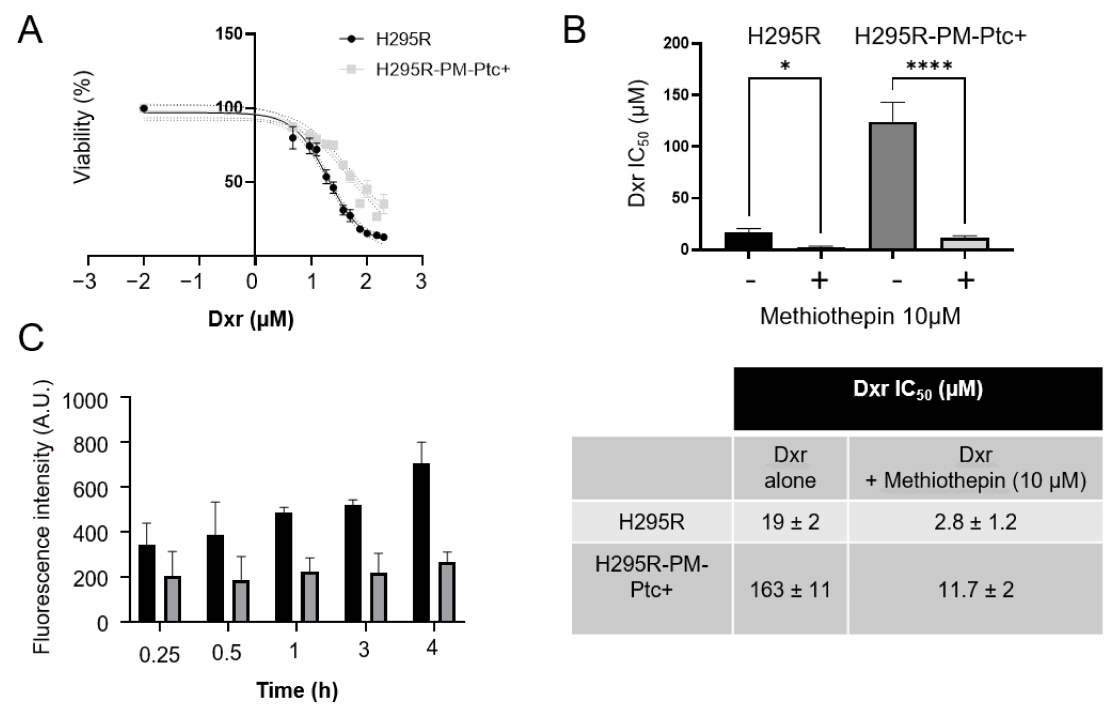
Figure 1. Gene structure of dog OCT1. ( A ) Sashimi plot showing OCT1 (SLC22A1) RNA-Seq Figure 2. H295R-PM-Ptc+ cells are more resistant to chemotherapy than parental cells . ( A ) Dox- reads from Beagle dog liver mapped onto chromosome 1 of the CanFam3.1 dog genome assembly. orubicin (dxr) cytotoxicity. H295R and H295R-PM-Ptc+ cells were treated for 48 h with increasing Exon junctions based on spliced reads are connected by lines, with the number indicating the concentrations of dxr before cell viability measure. ( B ) Doxorubicin IC50 of H295R-PM-Ptc+ and number of splice junctions mapped. RNA-Seq dataset PRJEB33381 from ENA at EMBL-EBI was H295R parental cells in the absence or the presence of 10 µ M of the Ptch1 efflux inhibitor methiothepin. used. ( B ) Exon-intron structure of dog OCT1 according to the CanFam3.1 genome assembly (top) ( C ) H295R-PM-Ptc+ cells accumulate less doxorubicin than parental H295R cells. Cells on coverslips and our experimental determination (bottom). The experimentally determined structure contains an were incubated with 2 µ M dxr for 15, 30, 60, 180 and 240 min and immediately fixed with PFA. Dxr additional exon between exons 2 and 3 of the CanFam3.1 genome assembly. ( C ) Schematic protein fluorescence was acquired using a filter for Alexa 594 and quantified using ImageJ software. About sequence alignment of human OCT1 (green) and dog OCT1 according to CanFam3.1 (grey) and 100 cells (from three wells) were scored per condition per experiment. All data presented are the our experimental results (blue). ( D ) Comparison of RNA-Seq coverage mapped onto dog OCT1 mean ± SEM of at least 3 independent experiments. Significance is attained at p -value < 0.05 (*), cDNA sequences according to CanFam3.1 (grey) and our experimental determination (blue). The (**** p < x-axis numbering represents the cDNA sequence based on the experimentally determined dog OCT1 sequence and the exon structure shown below. RNA-Seq datasets PRJNA396033 (Newfoundlander, Labrador Retriever, and Yorkshire Terrier) and PRJNA601830 (Boxer) from NCBI GEO were used. In contrast, when we mapped RNA-Seq datasets from dog kidney for OCT2 using the same reference genome (CanFam3.1), no differences between the annotated dog OCT2 gene structure (CanFam3.1) and the RNA-Seq datasets for kidney could be observed (Figure S2).